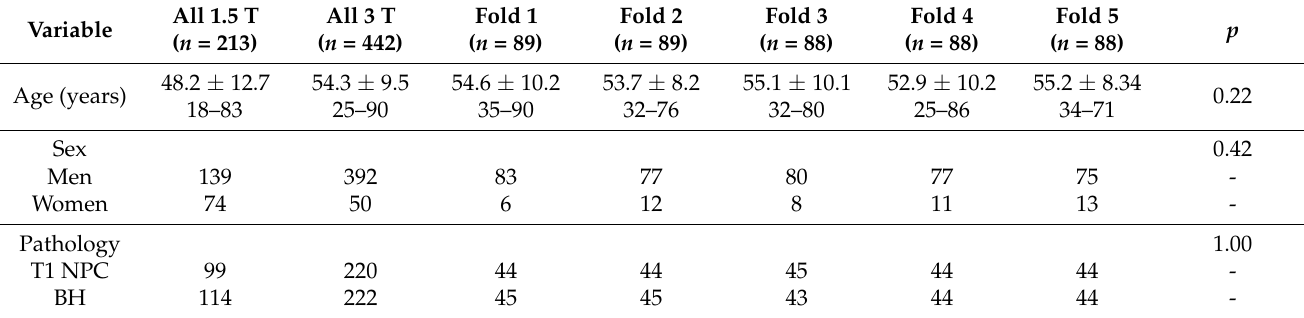
Table 2. Patient characteristics of the 3 T MRI training cohort and the 1.5 T testing cohort, as well as statistical analysis. Patients scanned with a 3 T MRI were sampled randomly with stratification, considering the ratio of nasopharyngeal carcinoma (NPC) to benign hyperplasia (BH), into five folds for later model building and cross validation. Non-parametric ANOVA was used to evaluate differences in characteristics across folds of 3 T MRI